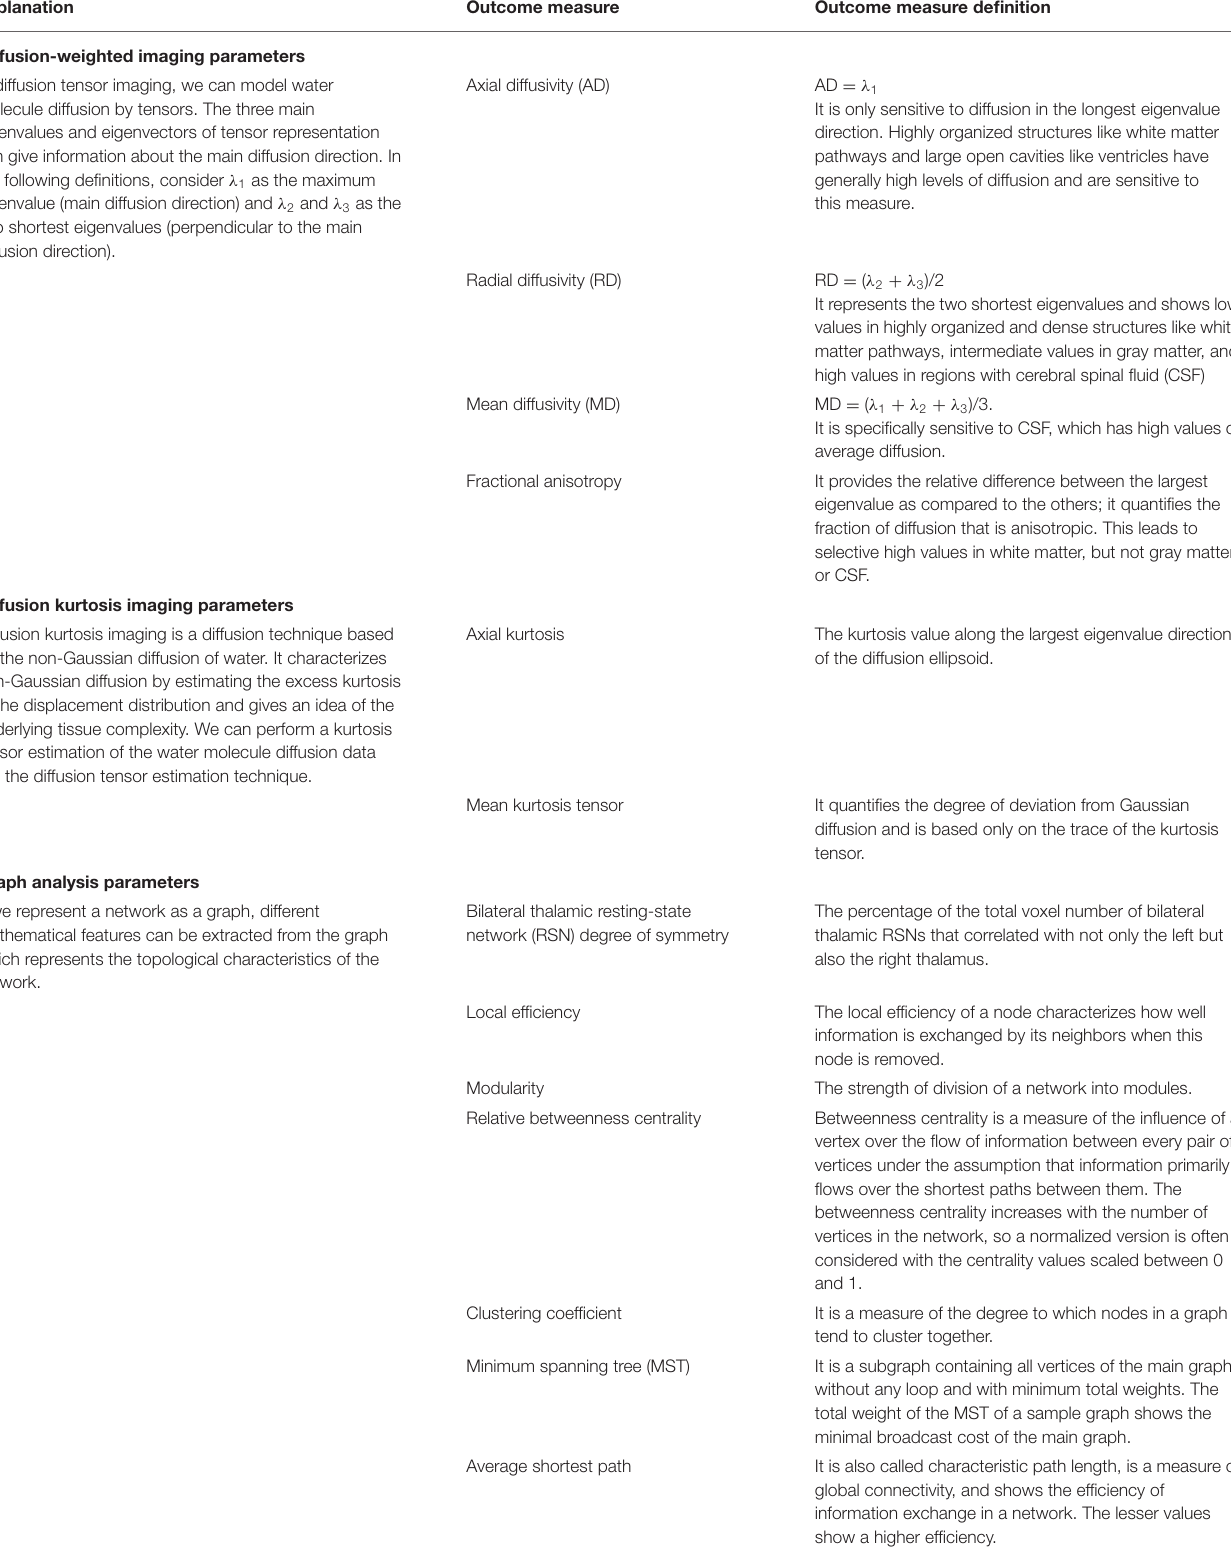
TABLE 2 | Definition of specific outcome measures in the reviewed